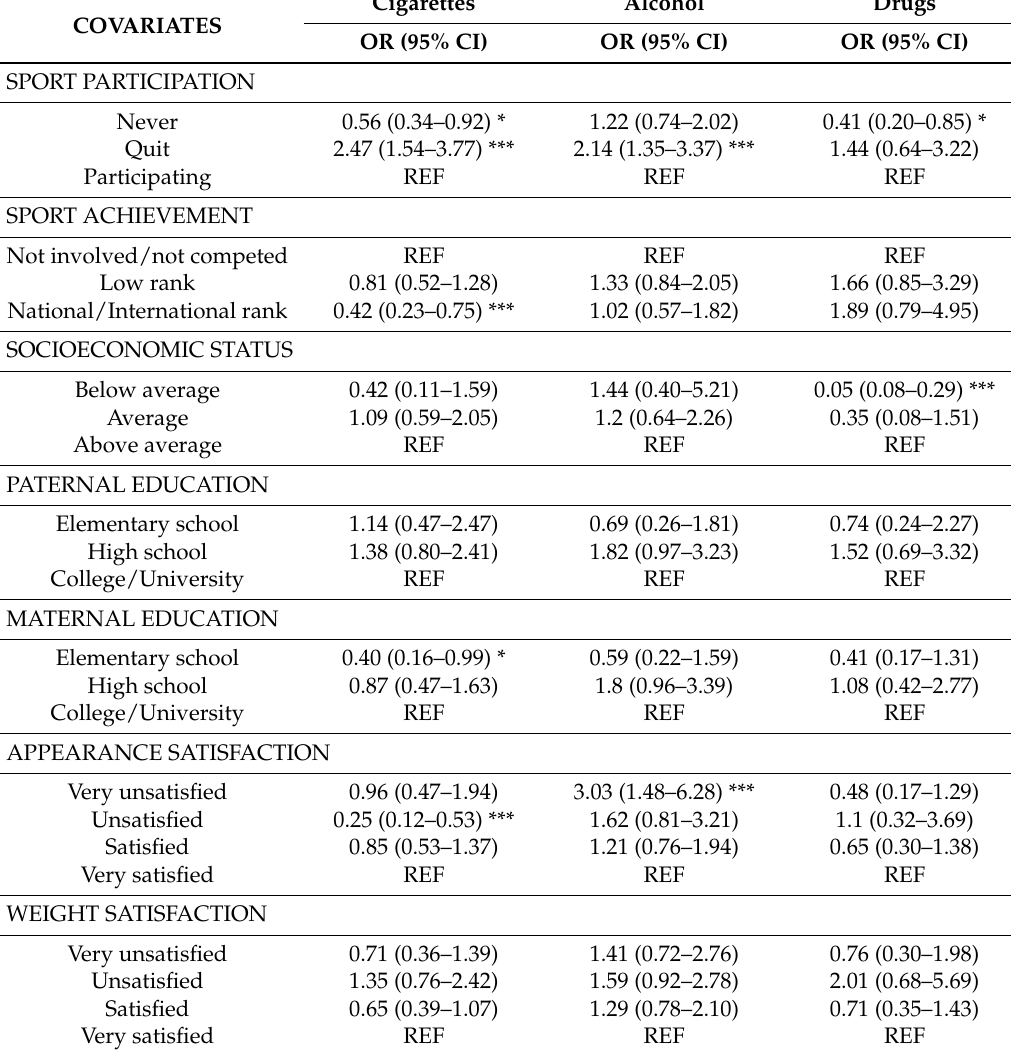
Table 3. Logistic regression calculations for Croatian